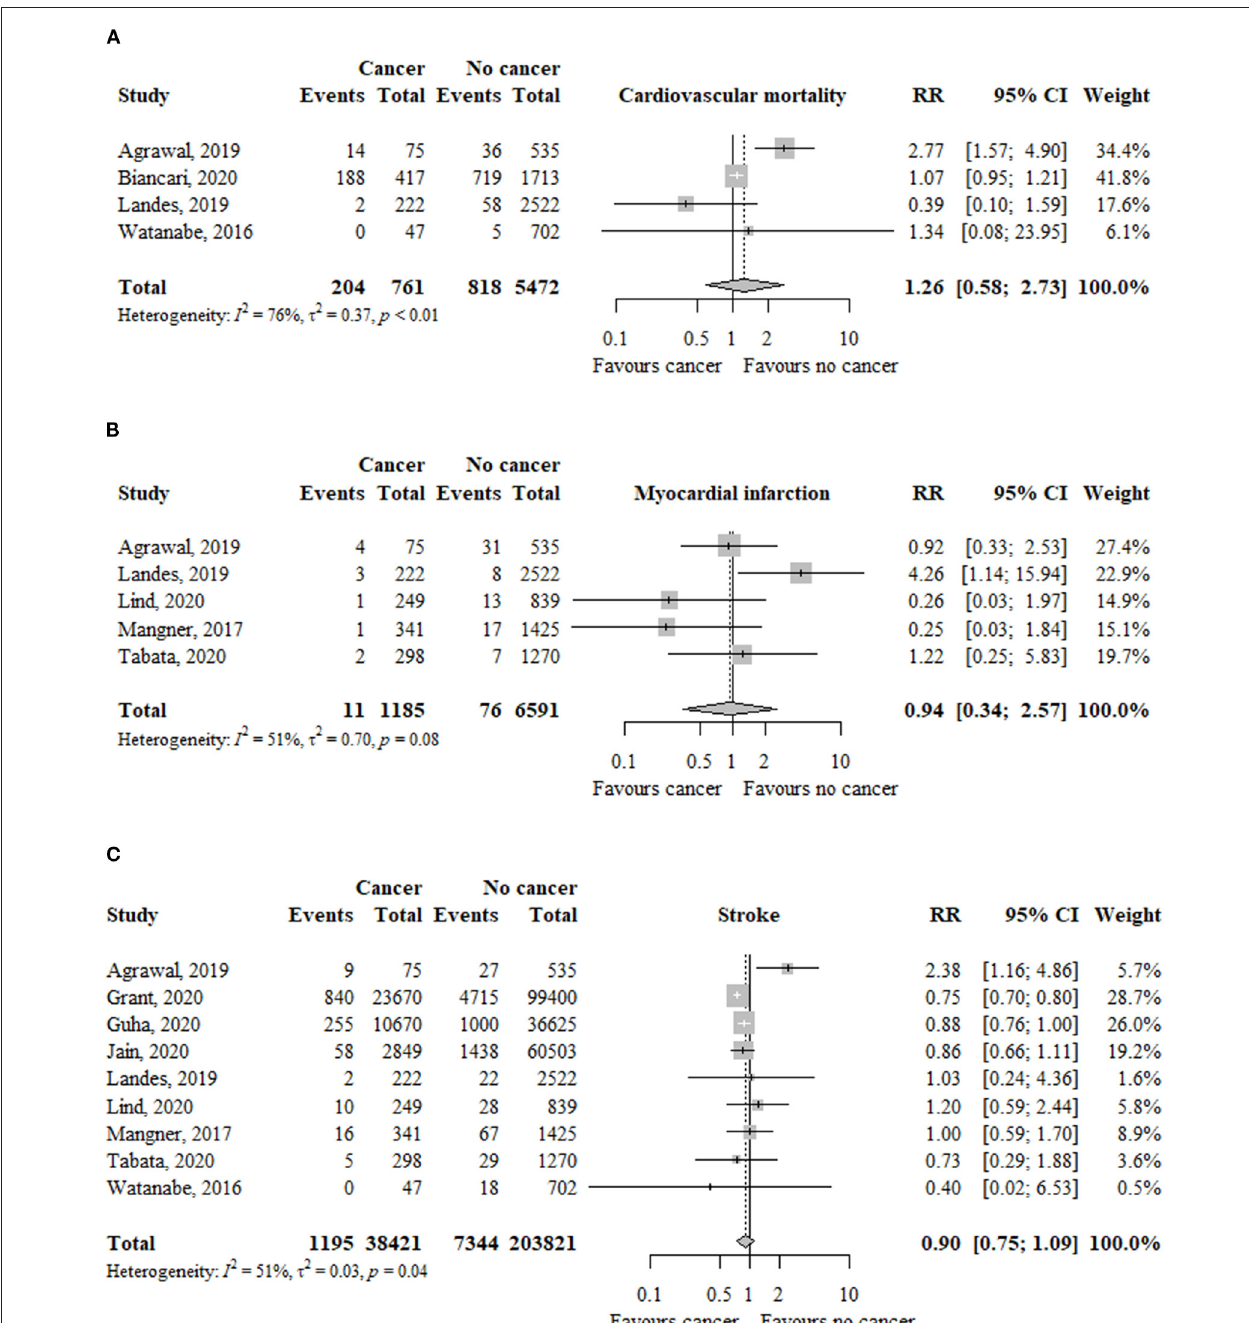
FIGURE 3 | Association between cancer and (A) cardiovascular mortality, (B) myocardial infarction, and (C) stroke in TAVR patients. RR, relative risk; aHR, adjusted hazard ratio; CI, confidence interval; TAVR, transcatheter aortic valve replacement.